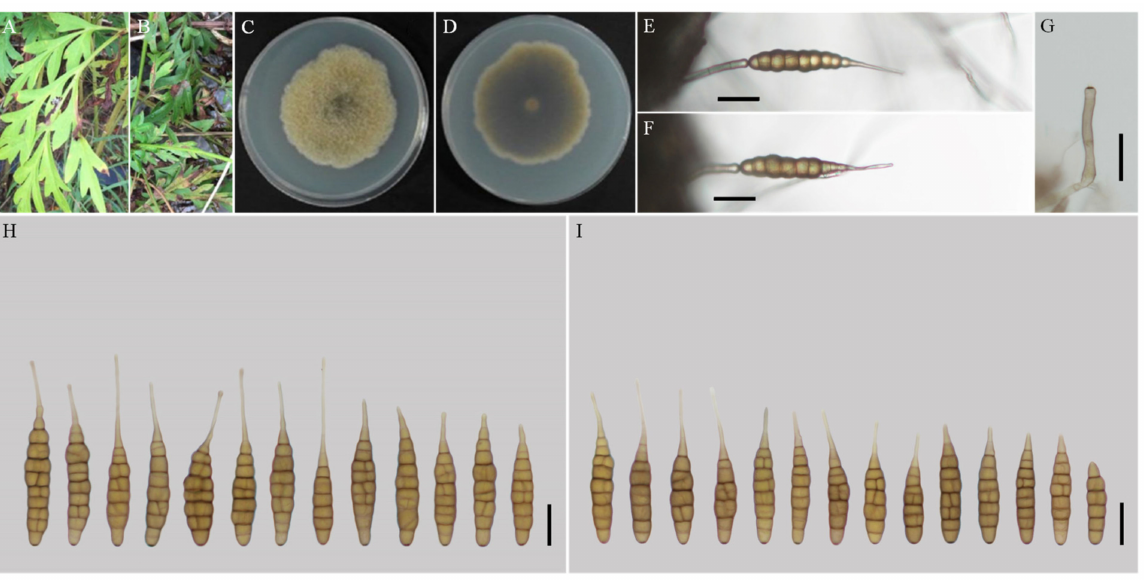
Figure 4. Morphology of Alternaria nanningensis sp. nov. ( A , B ) Natural symptoms of Cosmos sulphureus ; ( C , D ) Colony phenotypes (on PDA for 7 days at 25 ◦ C); ( E , F ) Sporulation patterns (on V8A at 22 ◦ C); ( G ) Conidiophores (on V8A at 22 ◦ C); ( H ) Conidia (on V8A at 22 ◦ C); ( I ) Conidia (on PCA at 22 ◦ C). Bars: ( E – J ) = 25 µ